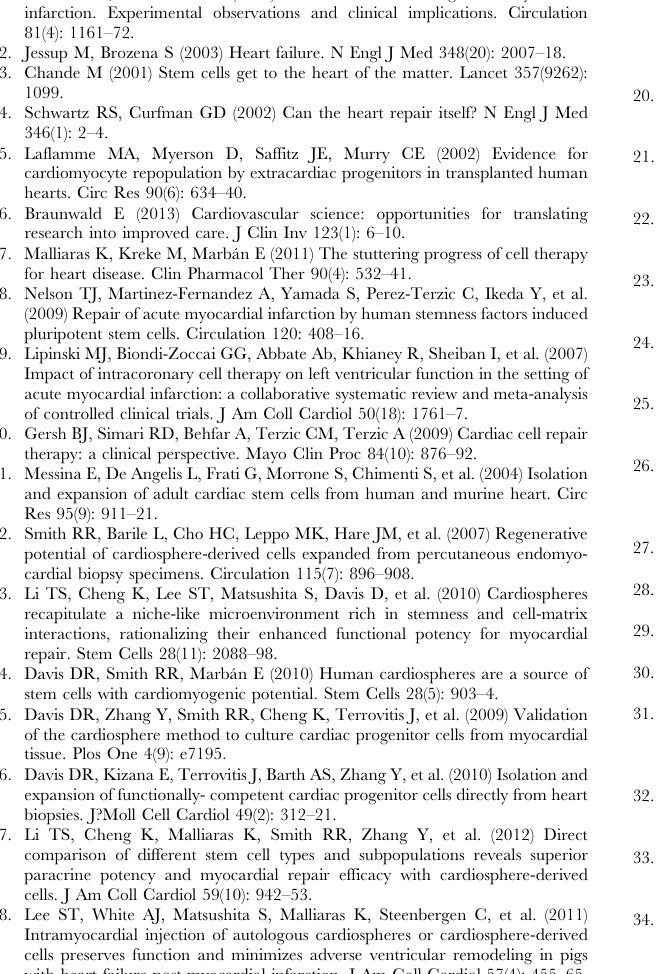
Figure S4 Cardiospheres stimulate angiogenesis. (A.D) Quantification of the capillary density with vWf staining and of the vessels’ density with sma staining in both border and remote regions. CSp treatment triggered significant neoangiogenesis even compared to the small MI group reflecting bona fide effect of CSpsin the vessel formation. Data are mean 6 SD. " p , 0.05 Figure S5 Collagen quantification. (A–C) Collagen content quantification by Picrosirius Red staining revealed a higher deposition in the LV on the small MI group associated with significantly increased content especially in the border zone compared to the CSp treated group. Data are mean 6 SD. " small MI.